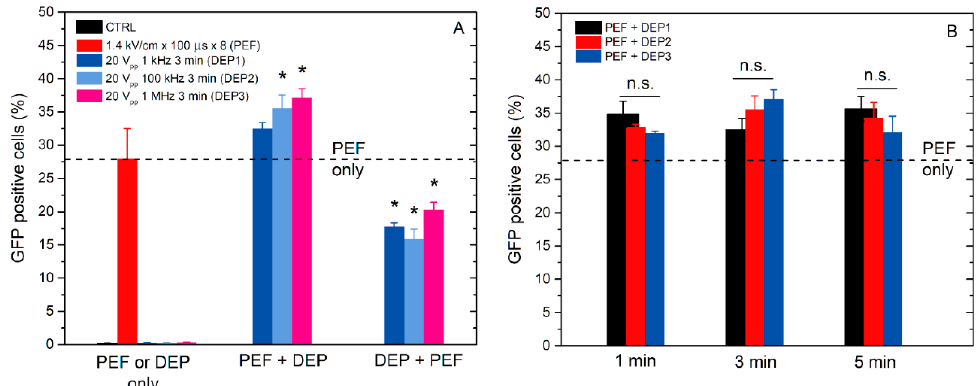
7 of 12 Figure 4. Spatial dependence of ∇ | E | 2 inside the cuvette .